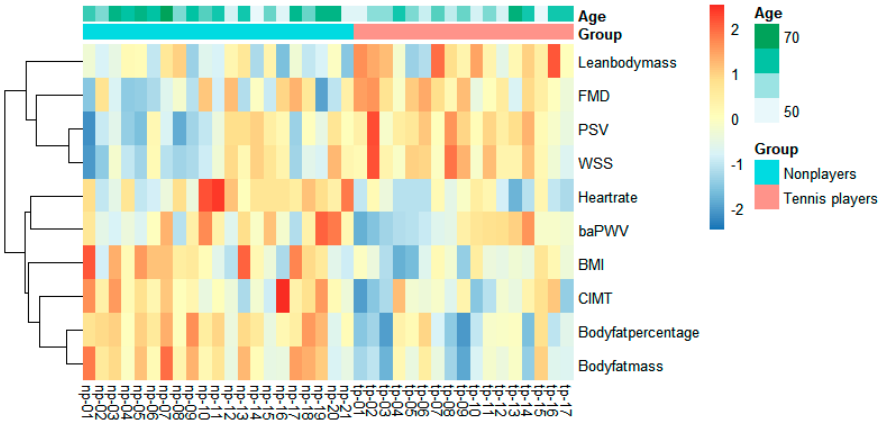
Figure 4. Clustered tendency of the measured parameters between the tennis players and non-players.